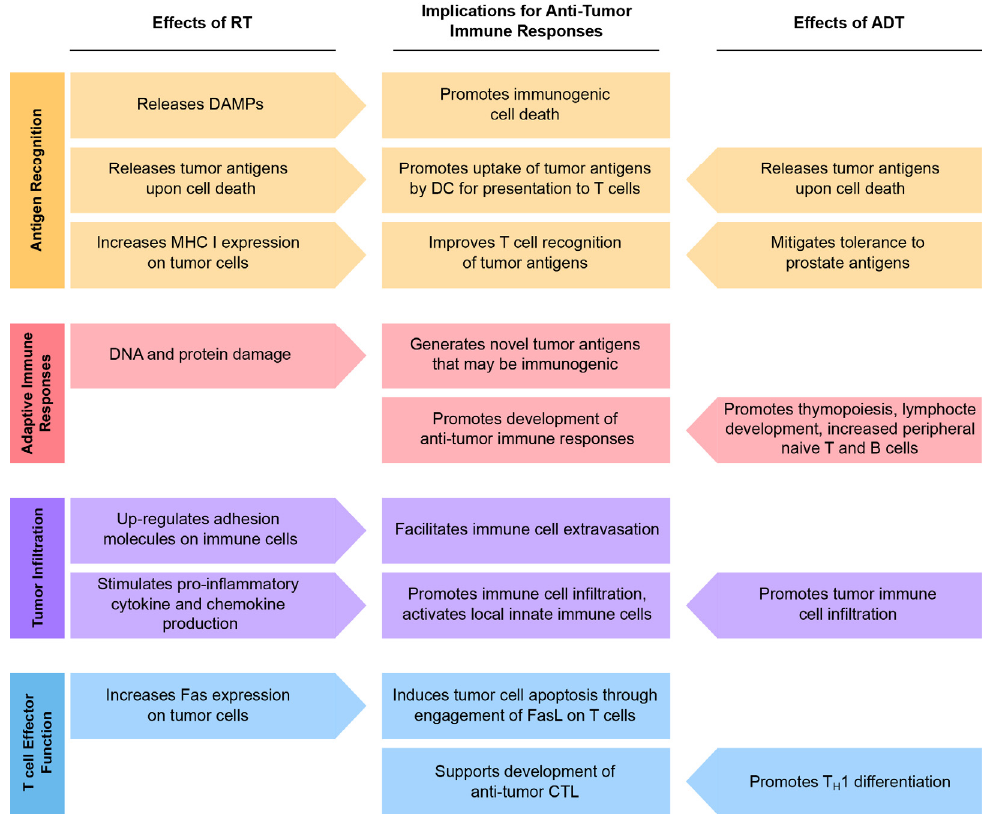
Figure 1. Cellular and molecular effects of ADT and RT as they relate to the development of anti-tumor immunity.